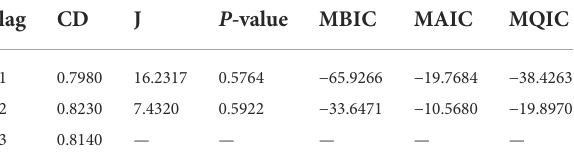
TABLE 3 Determination of the lag period.